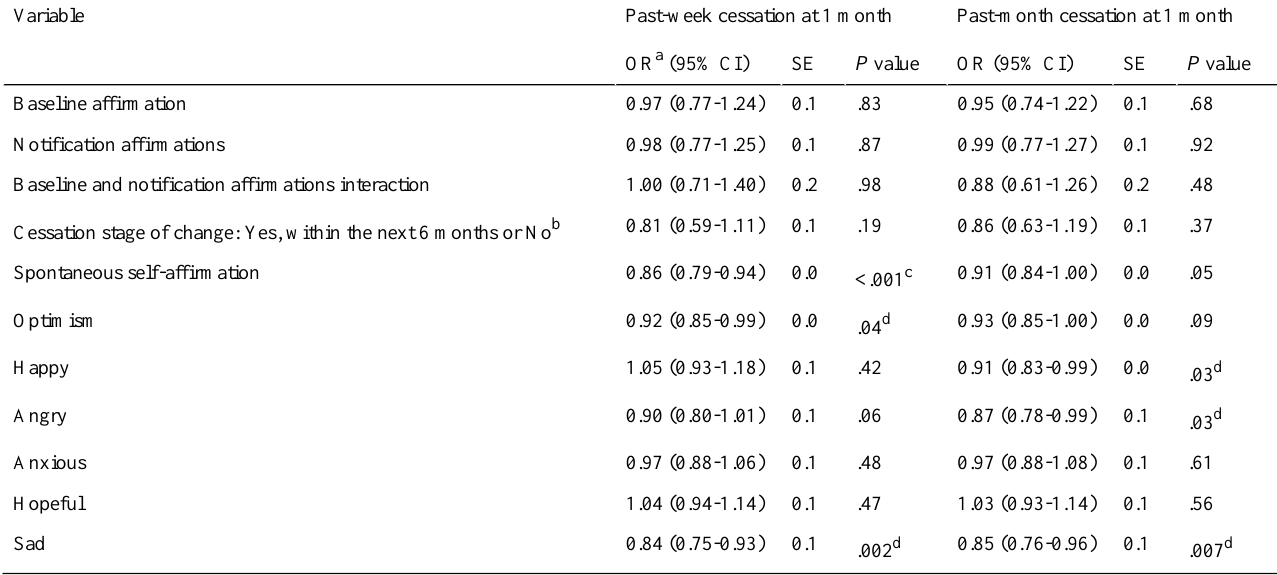
Table 4. Regression models with potential predictors (N=7899).